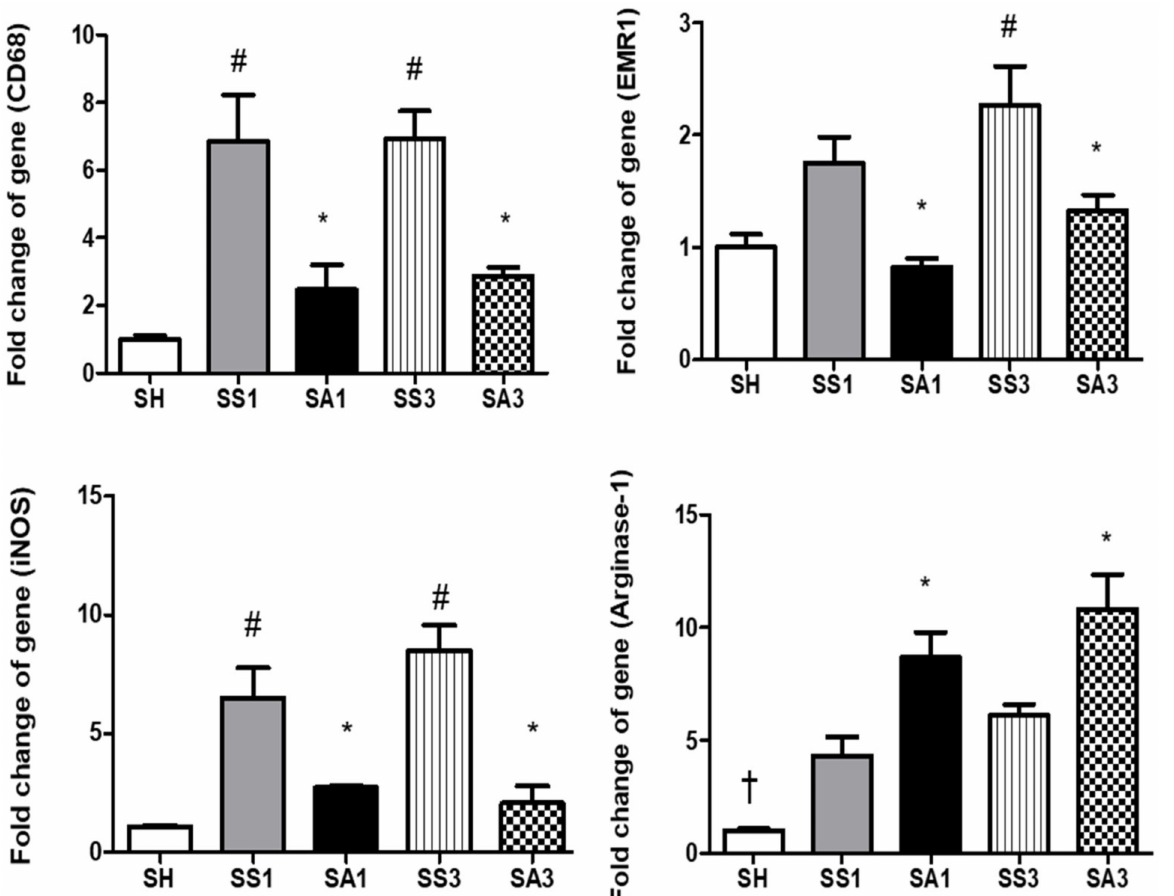
Figure 6. Messenger RNA expressions of macrophage infiltration markers in epididymal fat tissues. CD68, cluster of differentiation 68; EMR1, epidermal growth factor-like module-containing mucin-like hormone receptor-like 1; iNOS, inducible nitric oxide synthase. SH, sham group without a sleeve gastrectomy (SG) ( n = 8); SS1 and SS3, saline groups sacrificed on day 1 or 3 after the SG; SA1 and SA3, arginine groups sacrificed on day 1 or 3 after the SG. n = 10 for each SG group. Values are presented as the mean ± SEM. A two-way analysis of variance (ANOVA) with the Bonferroni post-hoc test was used to analyze differences among the SH and gastrectomy groups. + Significantly differs from the gastrectomy groups. # Significantly differs from the SH group. * Significantly differs from the SS group at the same time point ( p <